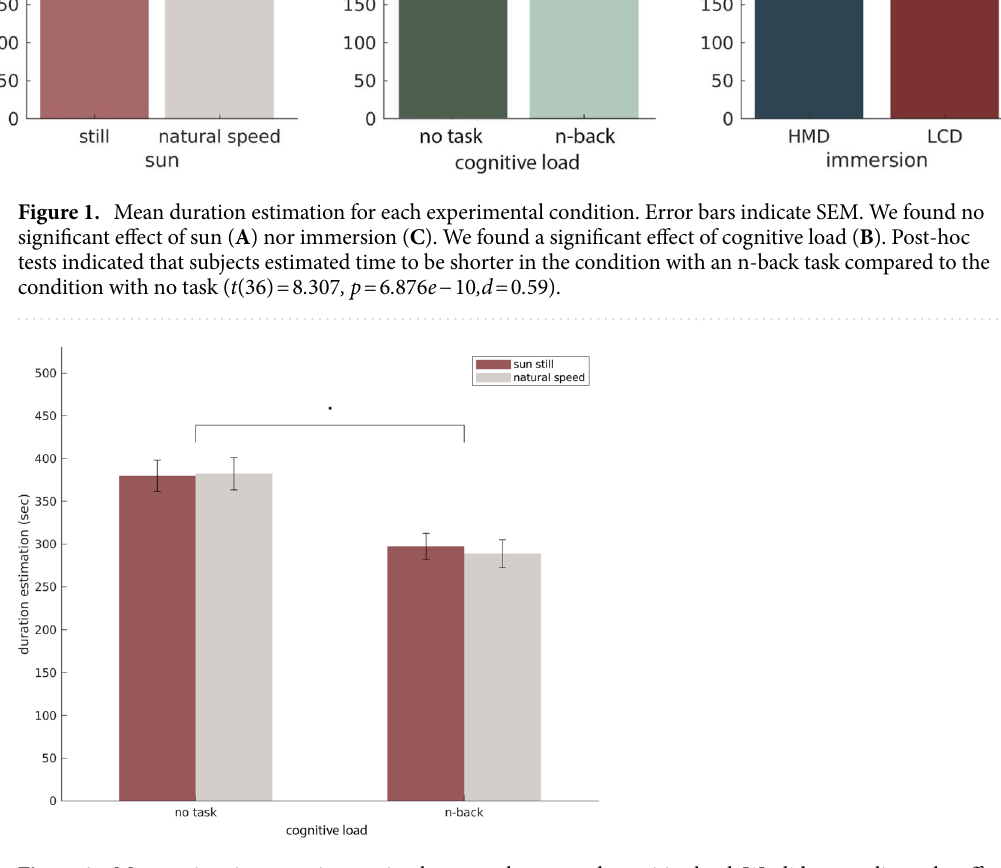
Figure 2. Mean estimation as an interaction between the sun and cognitive load. We did not replicate the effect from the original